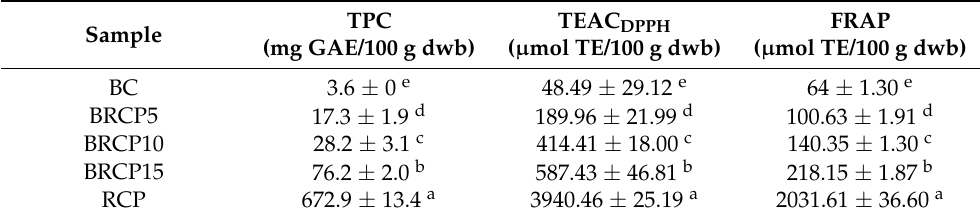
Table 4. Total phenolic content and antioxidant capacity of